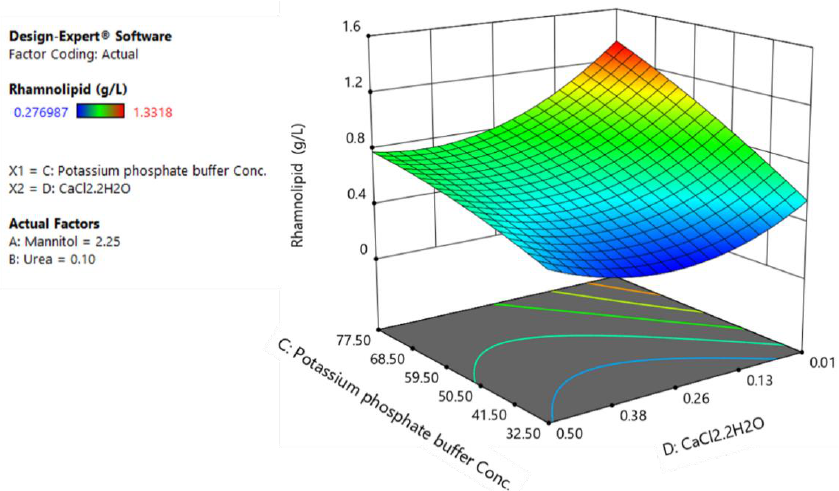
Figure 4. The response surface plot of rhamnolipids production as a function of potassium phosphate buffer and calcium chloride.